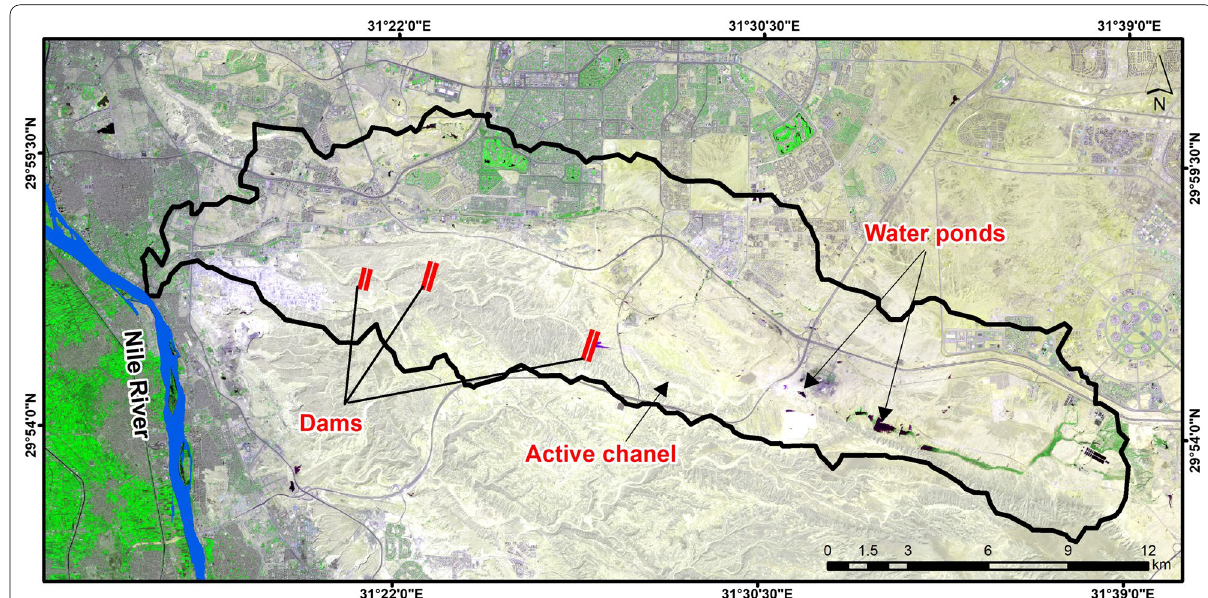
Fig. 13 Landsat satellite image showing the locations selected for the construction of storage dams according to active channel location in the Wadi